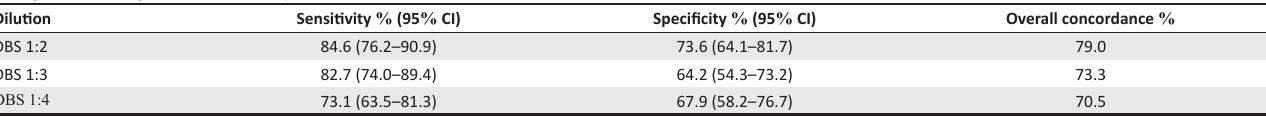
TABLE 2: Relative sensitivity, specificity and 95 % confidence intervals of dried bloodspot dilutions tested with the Kalon ELISA HSV2 assay compared with plasma among young women in Uganda, 2004–2005. † Dilution Sensitivity % (95 % CI) Specificity % (95 %